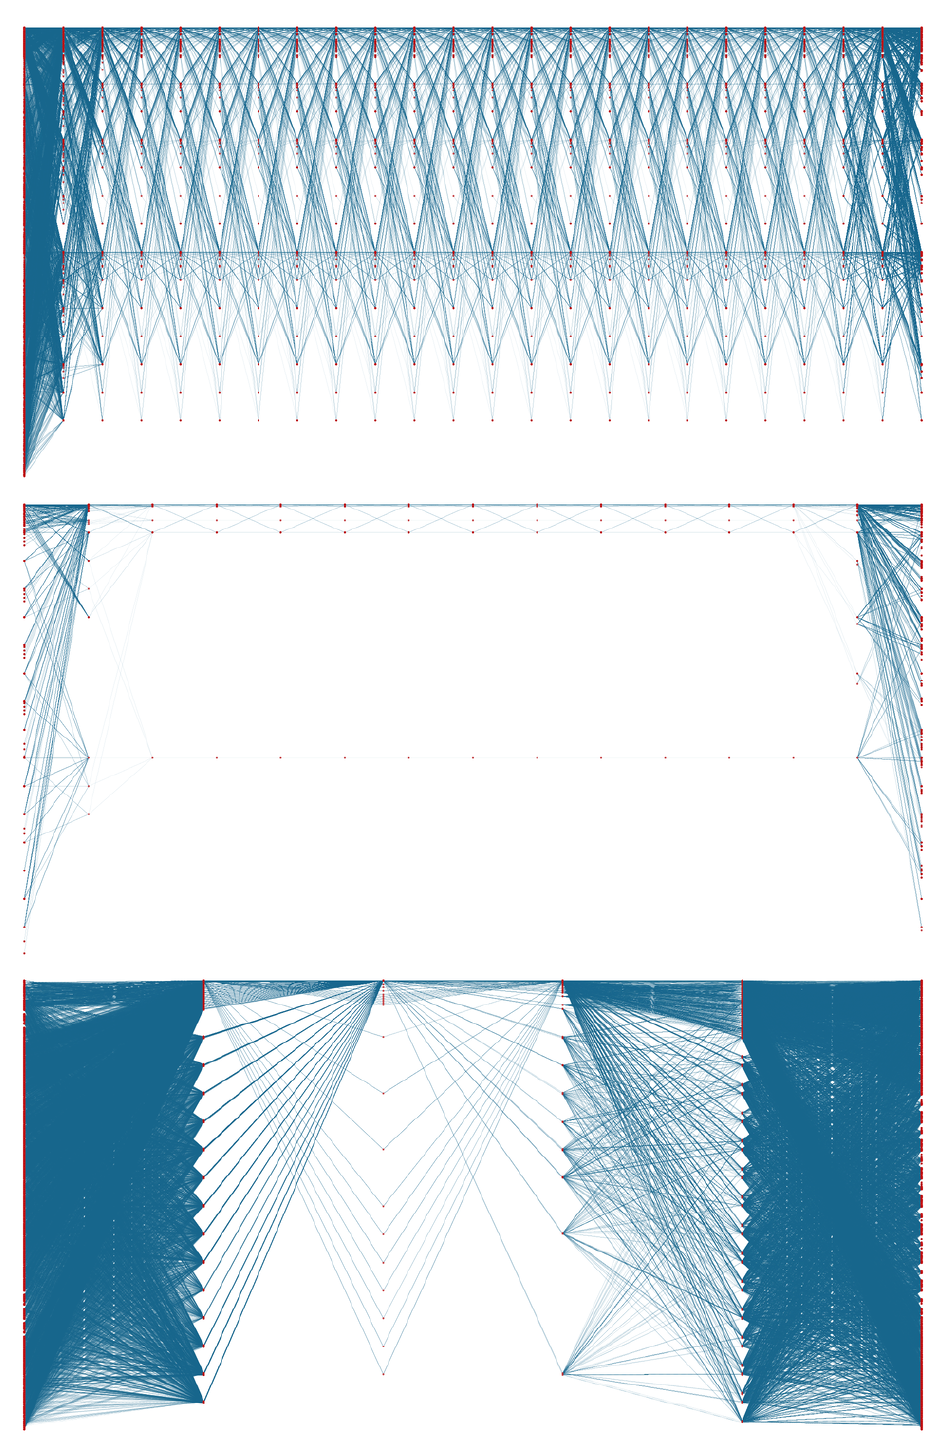
Figure 5: Examples of linear hull graphs generated by our algorithm. Top: 23 rounds of present using |A| = 2 24 . 7 single round approximations. Middle: 14 rounds of PRIDE , also with |A| = 2 24 . 7 . Bottom: 5 rounds of KLEIN , with |A| = 2 26 . 8 and using 2 17 anchoring